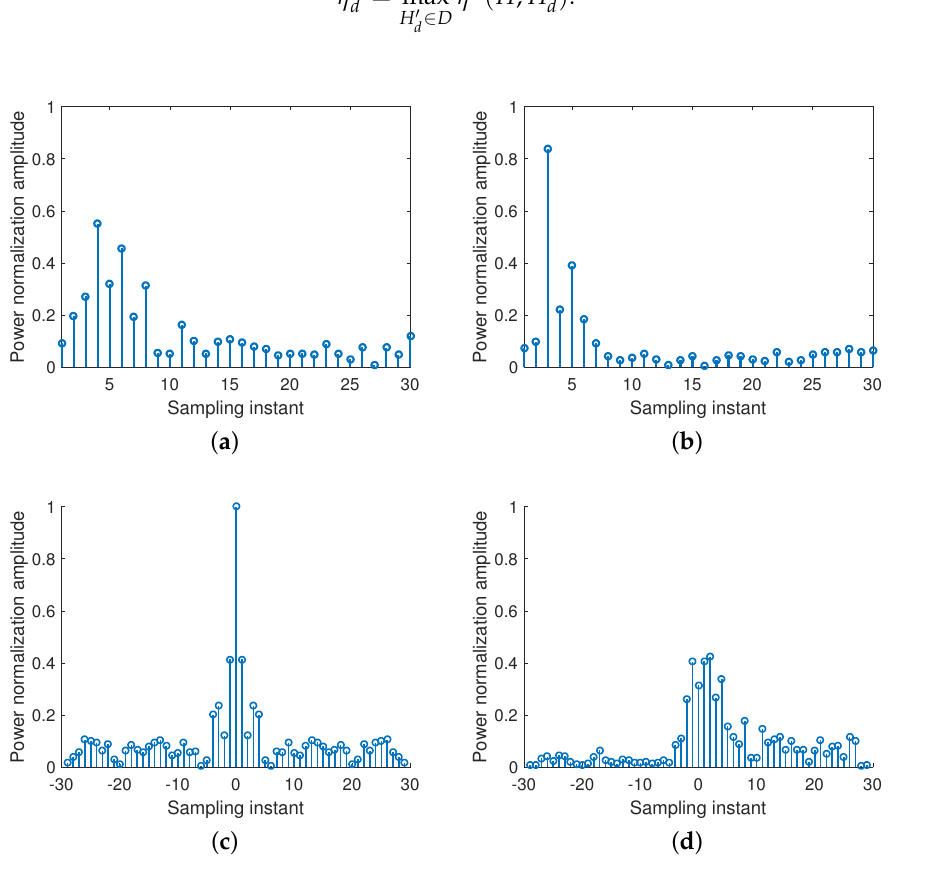
Figure 4. Focusing effect of Time-Reversal (TR). ( a ) Channel Impulse Response at location A. ( b ) Channel Impulse Response at location B. ( c ) Received TR signal at location A. ( d ) Received TR signal at location